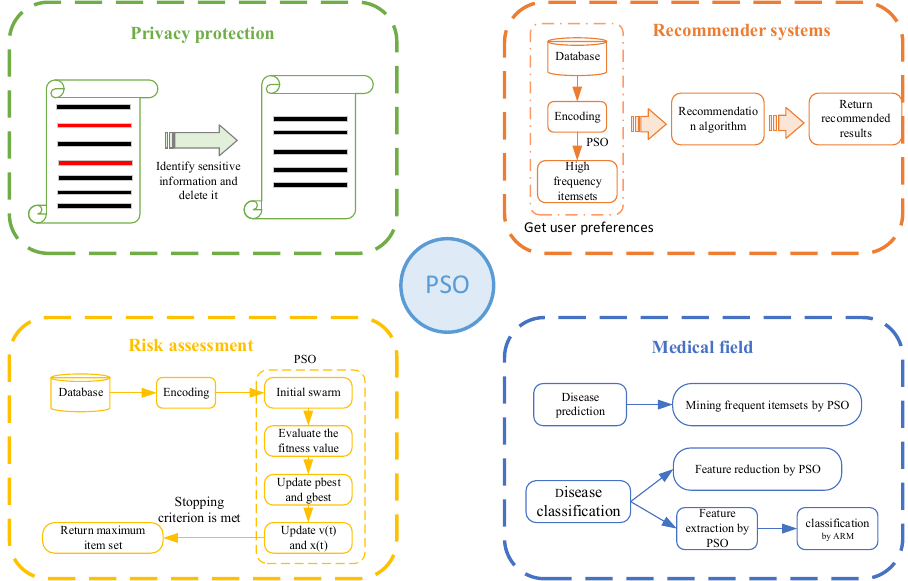
Figure 7. Application of particle swarm optimization algorithms.